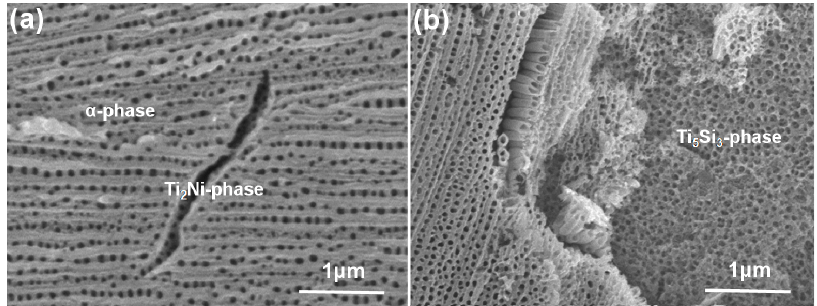
Figure 2. SEM images of scratched Ti-Ni-Si-O nanostructures showing: ( a ) nanotubes grown in the α -Ti phase region and Ti 2 Ni phase region; ( b ) nanopores grown in the Ti 5 Si 3 phase region. Table 2. Compositions in the α -Ti phase, Ti 2 Ni phase, and Ti 5 Si 3 phase regions after anodization. EDS Testing Areas